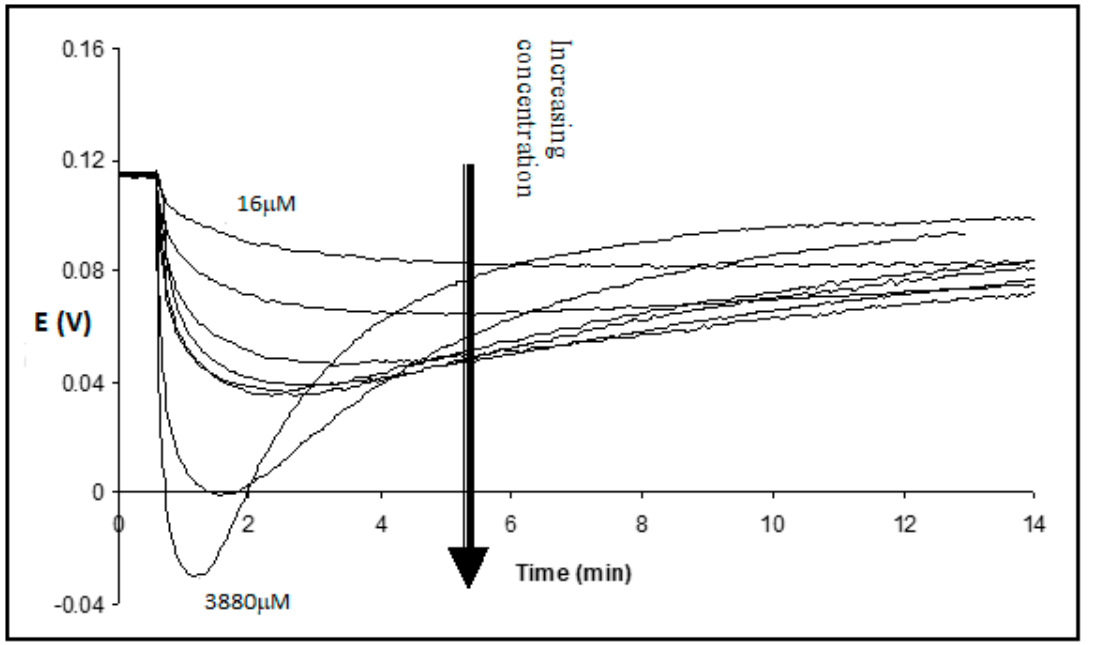
Figure 3. Transmembrane potential vs. time after the addition of Tergitol 15-S-7 in concentrations 16, 32, 64, 97, 130, 162, 800, and 3880 µM to the measuring (acceptor) chamber, containing the 5 mM buffer. The reference (donor) chamber contains 5 mM buffer + 0.5 M KCl.